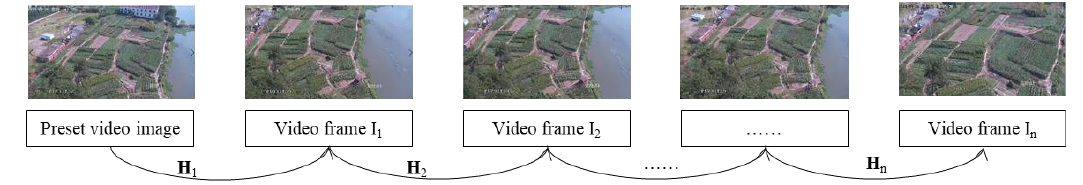
Figure 5. Transformations between adjacent video frames.